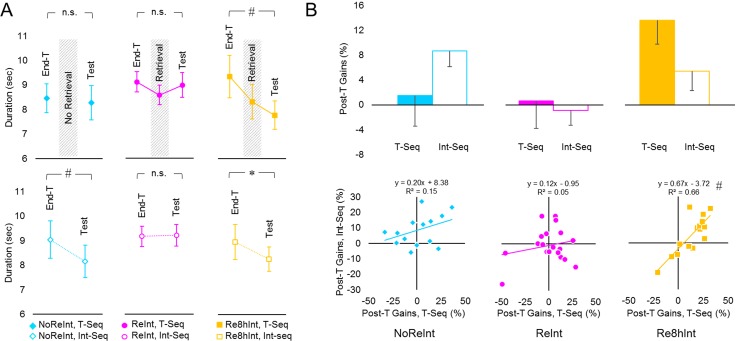
The effect of memory retrieval on performance rate.(A) Time to complete the last 30 key-presses during the last training block, the retrieval block and the first test block (End-T, Retrieval and Test respectively) is plotted for each group (NoReInt, ReInt and Re8hInt with blue, magenta and yellow markers respectively) and each sequence (T-Seq, filled markers upper plot; Int-Seq, empty markers lower plot). (B) Gains in performance, normalized to the last training block, that developed during the post-training interval for each sequence (i.e., between the end of training on Day 1 (T-Seq) or on Day 2 (Int-Seq) and the corresponding test session on Day 3; Post-T Gains) averaged across participants of each group (upper plot). Positive values correspond to faster performance by Day 3 than by the end of training. Individual Post-T Gains for the T-Seq (x axis) plotted against Post-T Gains for the Int-Seq (y axis) (lower plots). Bars–standard error of the mean (s.e.m.). *–significant results at .05 level, #–significant results at .01 level, n.s.–no significant differences. Note that in the ReInt group, regression analysis did not result in significant correlation even after excluding two participants with extremely negative values.